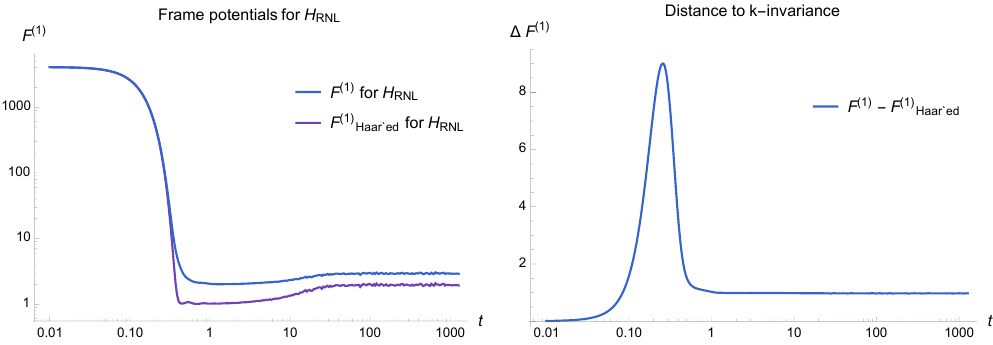
Figure 7 . On the left we plot the (cid:12)rst frame potential F (1) for H RNL along side the (cid:12)rst frame E RNL potential for its Haar-invariant extension F (1) , computed numerically using the 2-point form factor e E RNL as in eq. (4.15). On the right we plot the di(cid:11)erence, measuring the 2-norm distance to 1-invariance and observe approximate 1-invariance at late